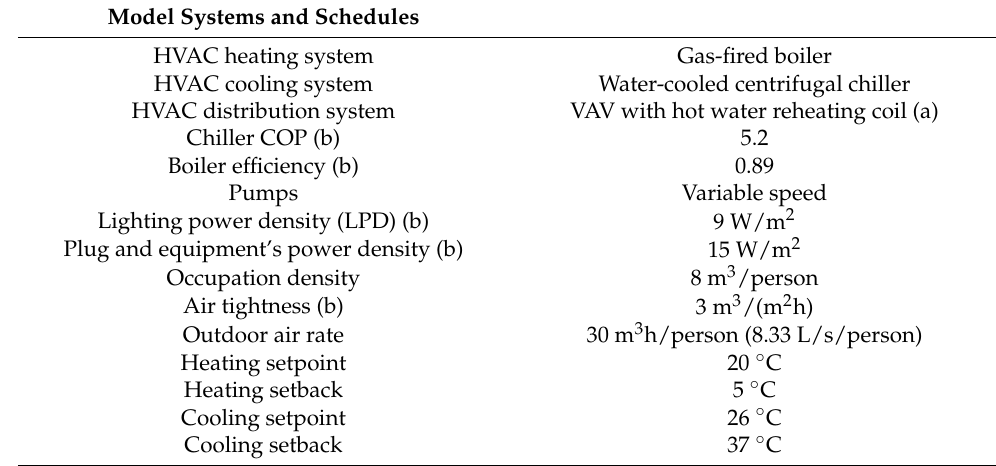
Table 5. Summary of the BEM baseline simulated systems and schedules according to Feng et al.